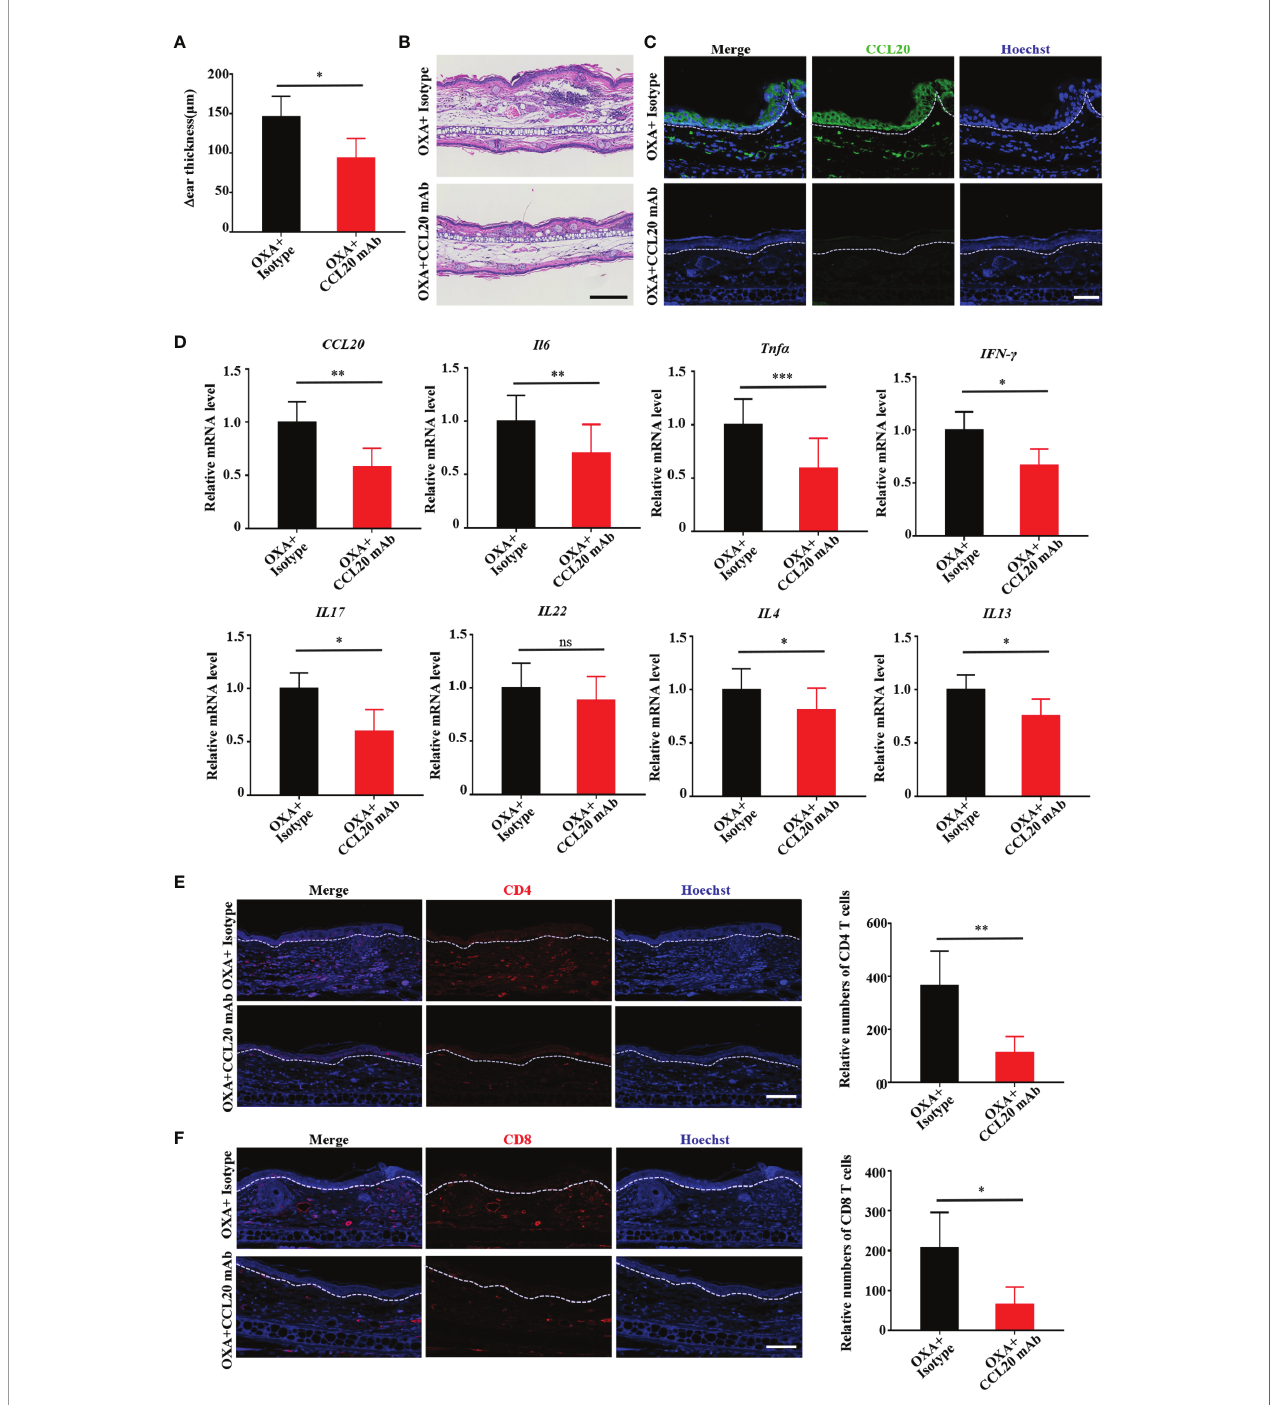
FIGURE 4 | Neutralizing CCL20 alleviates OXA-induced ACD-like skin in fl ammation in vivo. (A) Examination of ear thickness in OXA-induced mice treated with or without the CCL20 mAb, n = 3 per group. (B) H&E staining of sections from OXA-induced mice treated with or without the CCL20 mAb. Scale bar, 100 m m, n = 3 per group. (C) Immuno fl uorescen-ce staining for CCL20 (green) and Hoechst (blue) from OXA-induced mice treated with or without the CCL20 mAb. Scale bar, 20 m m, n = 3 per group. (D) Relative CCL20, Il6 , Tnfa , IFN- g , Il17 , Il22 , Il4 and Il13 mRNA expression in epidermal tissues from mouse biopsies was analyzed by qRT-PCR, n = 3 (mean ± SD). (E, F) Immuno fl uorescence staining for CD4 and CD8 + T cells and relative numbers in sections from OXA-induced mice treated with or without the CCL20 mAb. CD4 (red), CD8 (red), and Hoechst (blue). Scale bar, 20 m m. Data represent the mean ± SD ( n = 3). * p < 0.05, ** p < 0.01, *** p < 0.001, ns, not signi fi cant. All the bars represent at least average of three independent